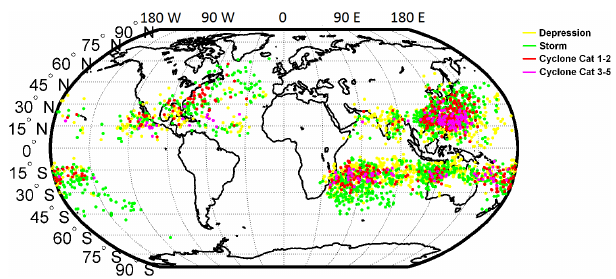
Figure 9. Distribution of possible overshootings for different storm categories: tropical depression (yellow), tropical storm (green), tropical cyclone categories 1 and 2 (red) and tropical cyclone cate- gories 3 to 5